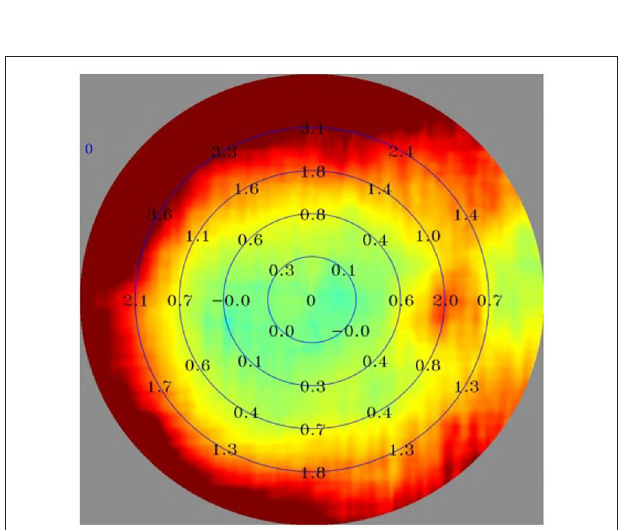
FIGURE 2 | Result of MRT: The innermost circle stands for RDV-10; The second circle stands for RDV-20; The third circle stands for RDV-30; The fourth circle stands for RDV-40.